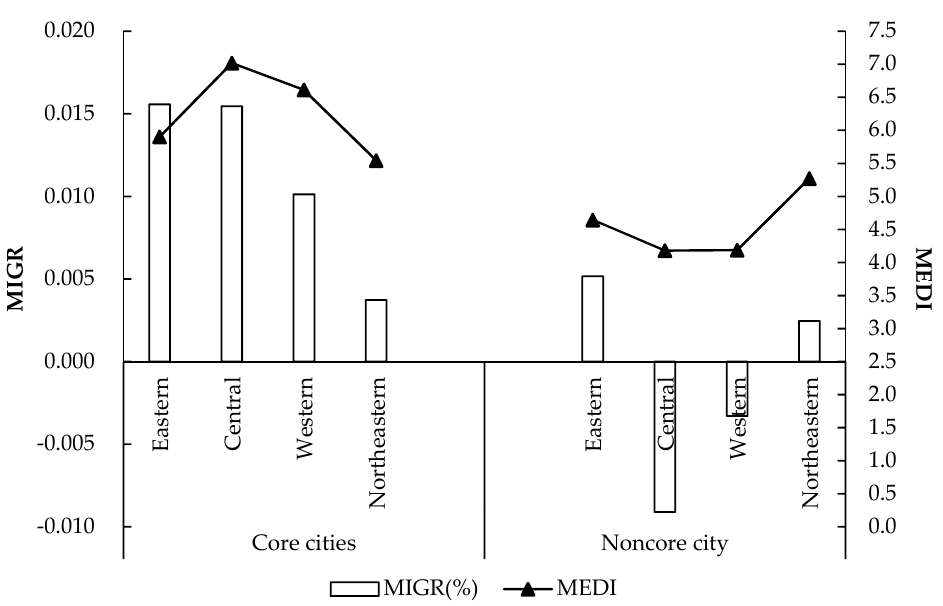
Figure 4. Population flow rate and the level of medical and health services in cities in different economic regions. Table 7. Test of the effect of the HSR connection under different types of heterogeneity.